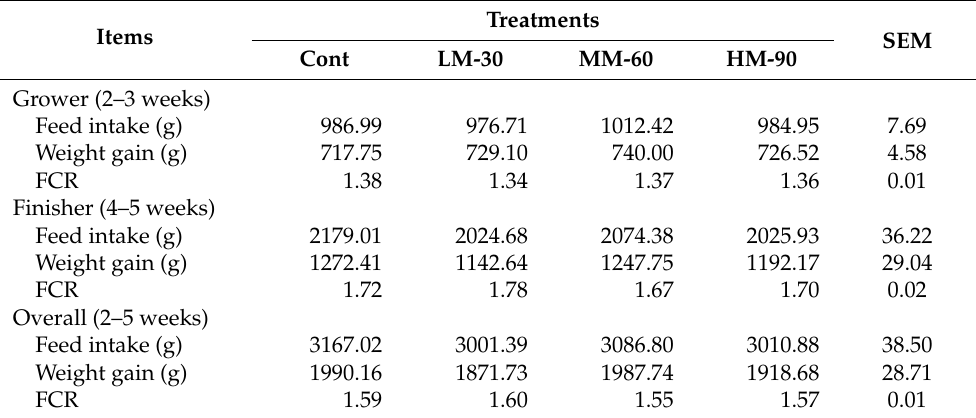
Table 4. Effect of β -mannanase supplementation on growth performance in broilers fed low en- ergy